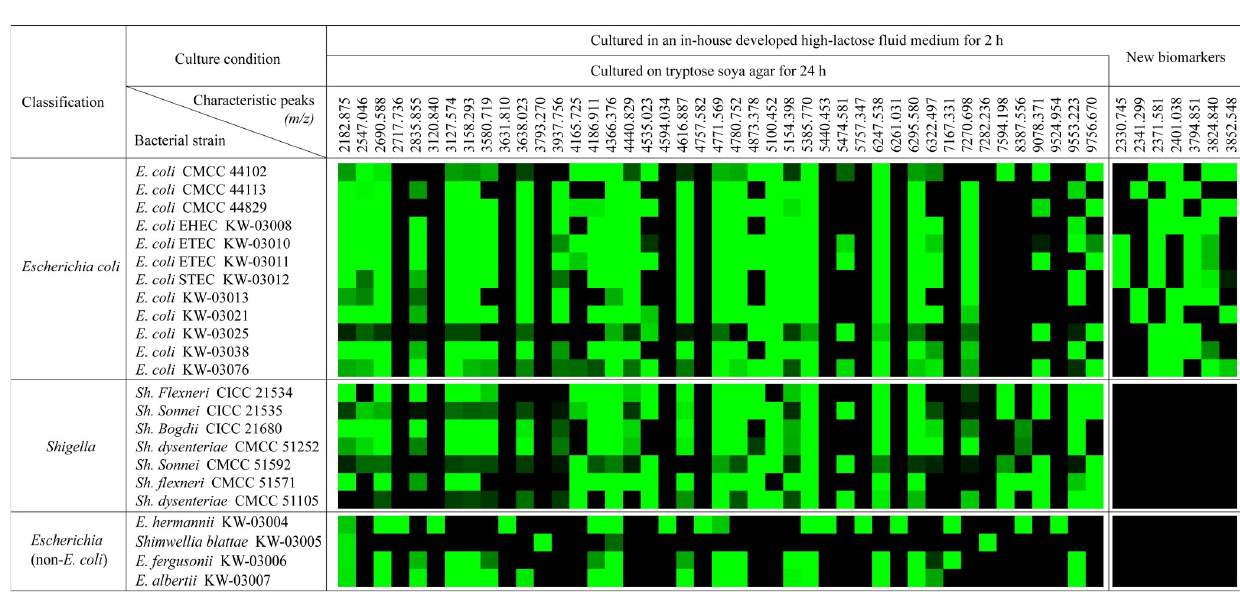
Fig 2. Coloured heat map of the characteristic MS peaks. Coloured heat map showing the characteristic MS peaks in the spectra from the E . coli , Shigella and other four Escherichia strains. The relative intensity of the MS peak was categorized using Hierarchical Clustering Explorer 3.0. Blocks, with a relative intensity equal to 0 shown in black; blocks with a relative intensity less than 10% are shown in dark green; blocks with a relative intensity between 10% to 100% are shown in bright green. E ., Escherichia ; Sh ., Shigella .